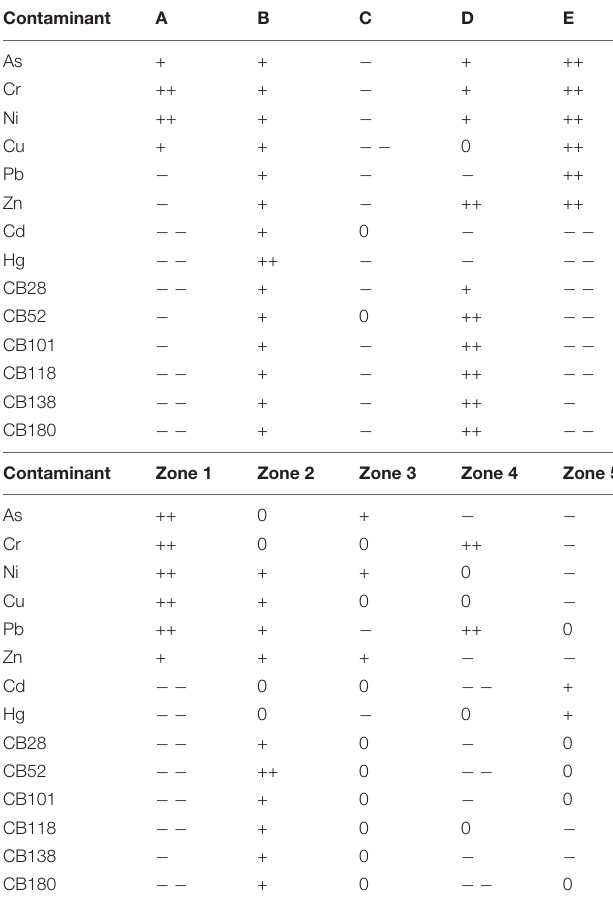
The cluster group and cluster zone medians are compared to the median for the whole BPNS per contaminant: − − very low level (below quantile 0.25), − low level (between quantiles 0.25 and 0.45), 0 normal level (between quantiles 0.45 and 0.55), + high level (between quantiles 0.55 and 0.75), ++ very high level (above quantile